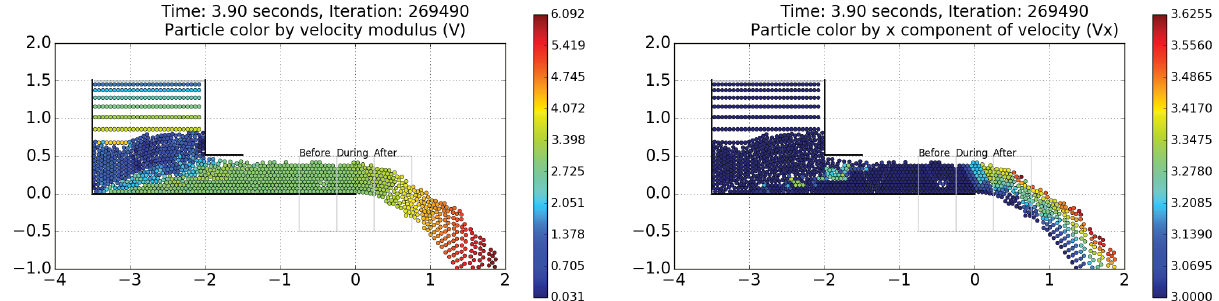
Figure 1. The simulated system: A basic conveyor with a particle inlet at the top left, a moving belt with constant velocity from left to right and three regions of interest (named “Before", “During" and “After") for data collecting. Left: Particles colored by they velocity modulus V , color scale automatically adjusted from minimum do maximum values in that frame. Right: Particles colored by they V x , color scale set for range 3.0m / s(belt velocity) to 3.7m / s, for detail enhancement and better visualization of the e ff ect. Note the V x increasing that appears during the transition from forced flow to free fall, as well a velocity gradient from bottom to top is visible.